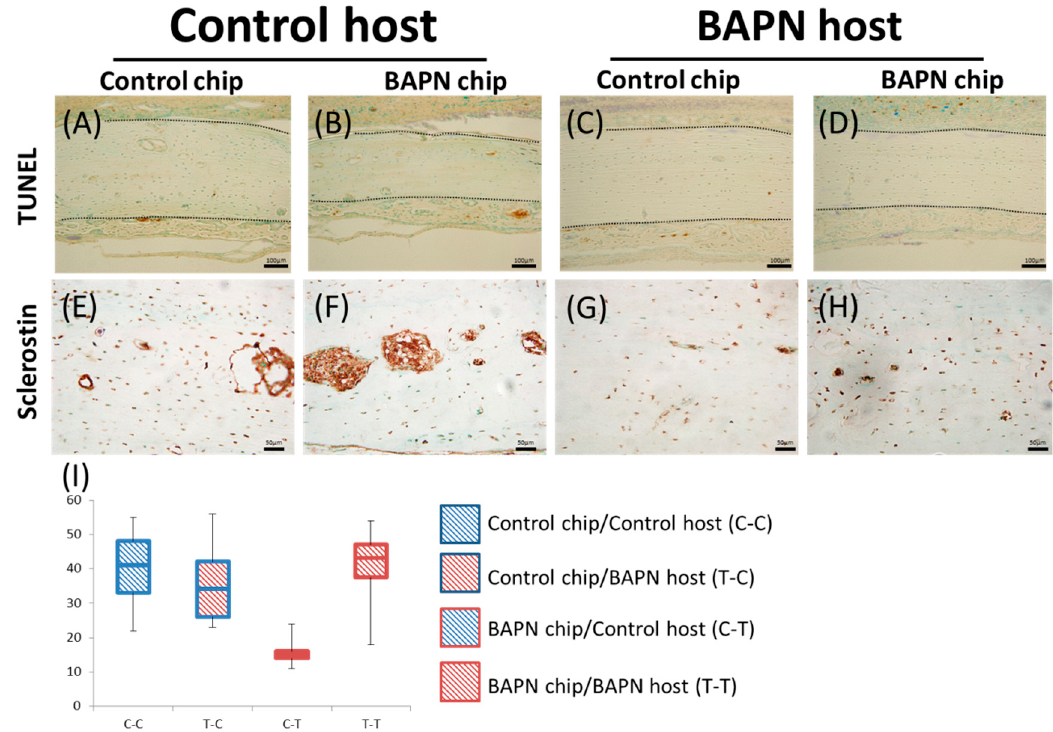
Figure 5. Histological findings of TUNEL and sclerostin staining of transplanted bone chips. ( A – D ) Histologically, no difference is seen in apoptosis as represented by TUNEL staining among all chips; ( E – H ) Histological expression of sclerostin does not show any difference; ( I ) Ratio of osteocytes expressing sclerostin to osteocytes in histological sections. No significant difference is seen among all transplanted bone chips. Dotted line defines the transferred bone. Magnification, ×40.